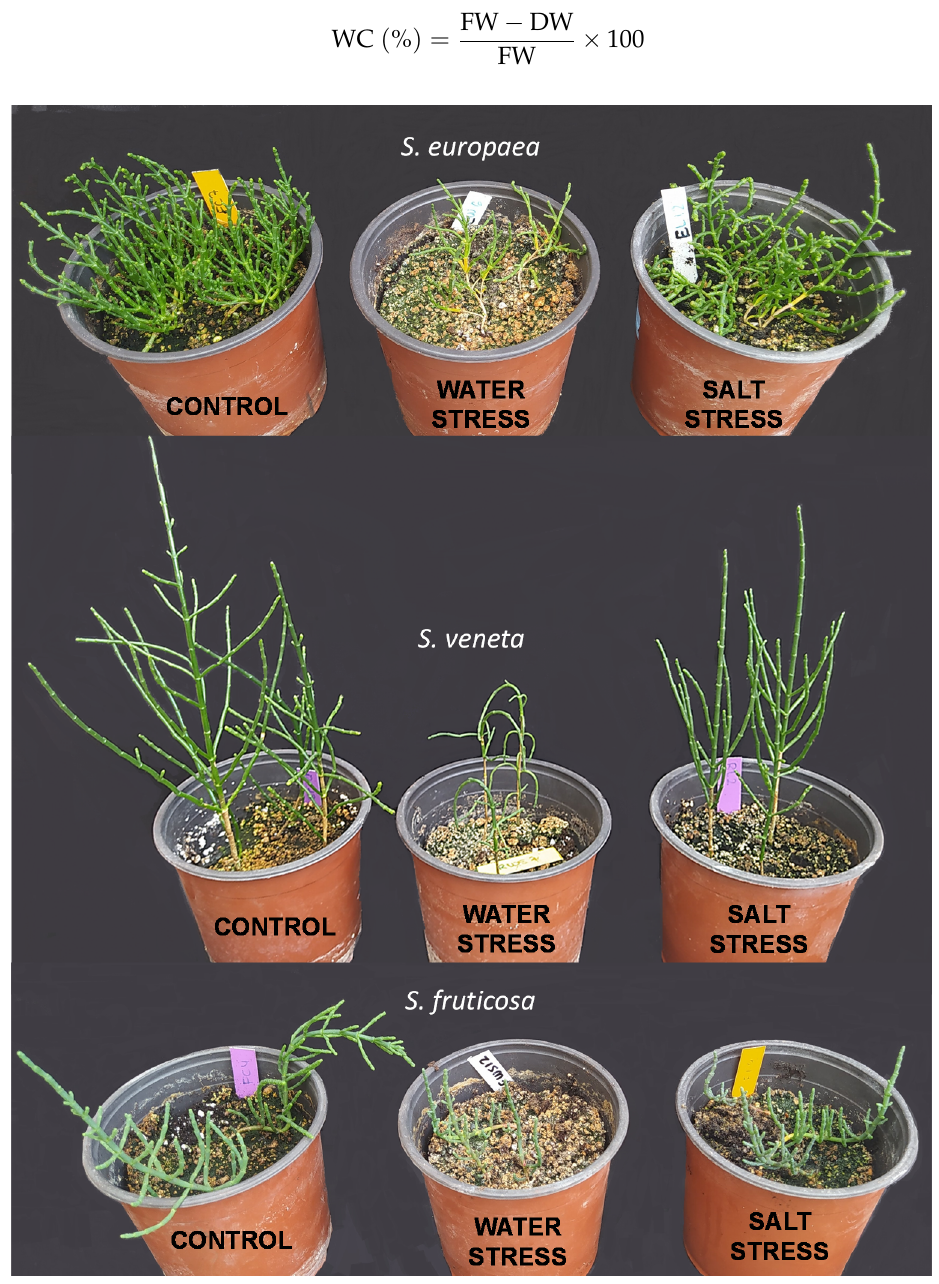
Figure 10. Picture of the three halophytes species after thirty days of stress treatments: control; water stress (complete withholding of irrigation); salt stress (watering with 700 mM